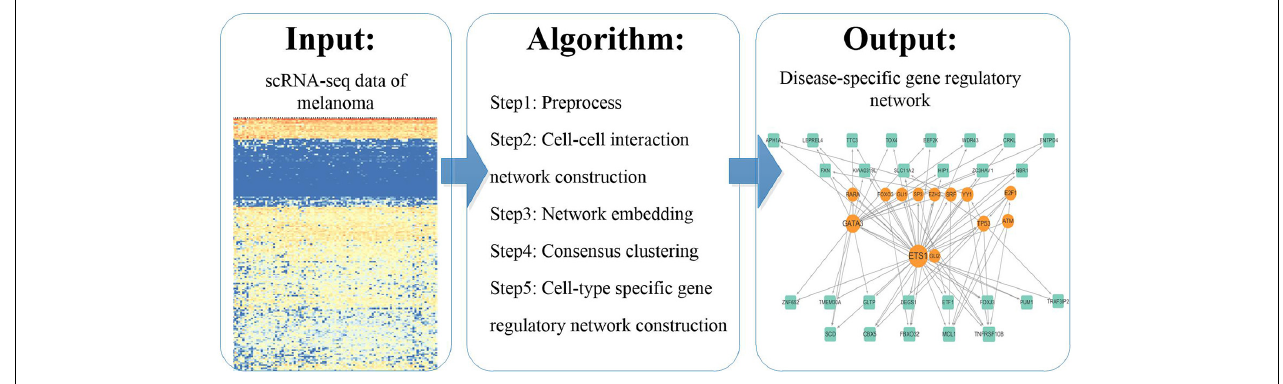
FIGURE 1 | The pipeline of the study.